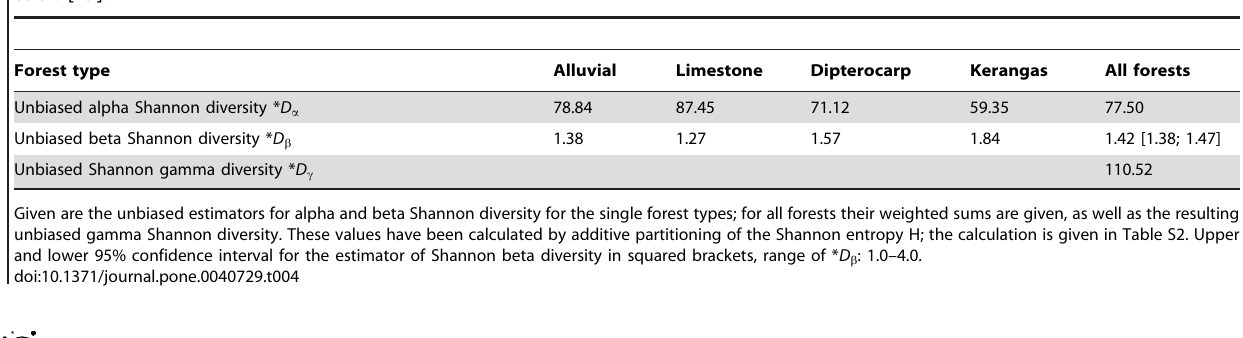
Table 4. Unbiased estimations of alpha, beta and gamma Shannon diversity* D according to the partitioning procedure of Marcon et al. [19].